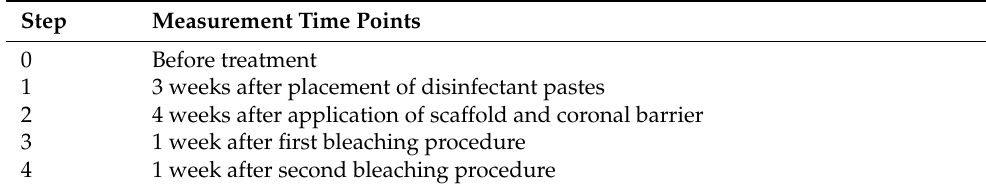
Table 2. Measurement time points for a specific step.